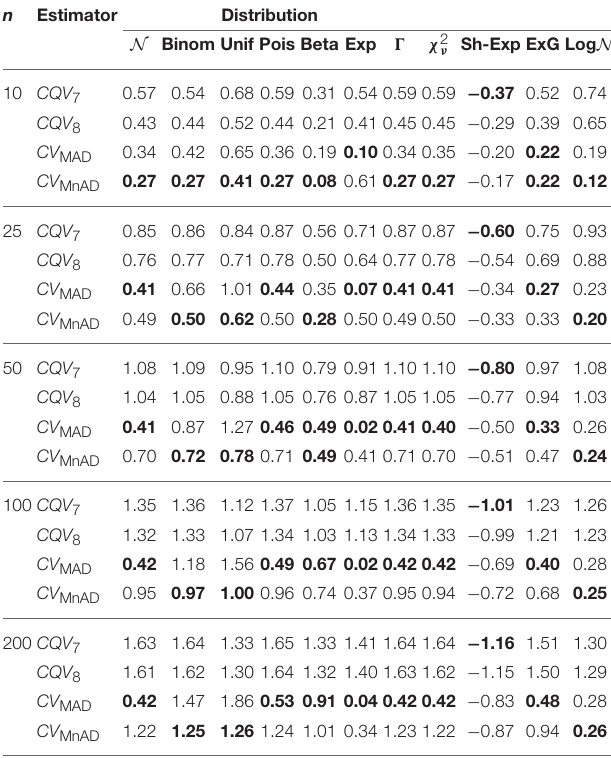
TABLE 10 | Median values of log 10 ( γ ) accuracy metric across θ produced for each estimator and sample sizes by